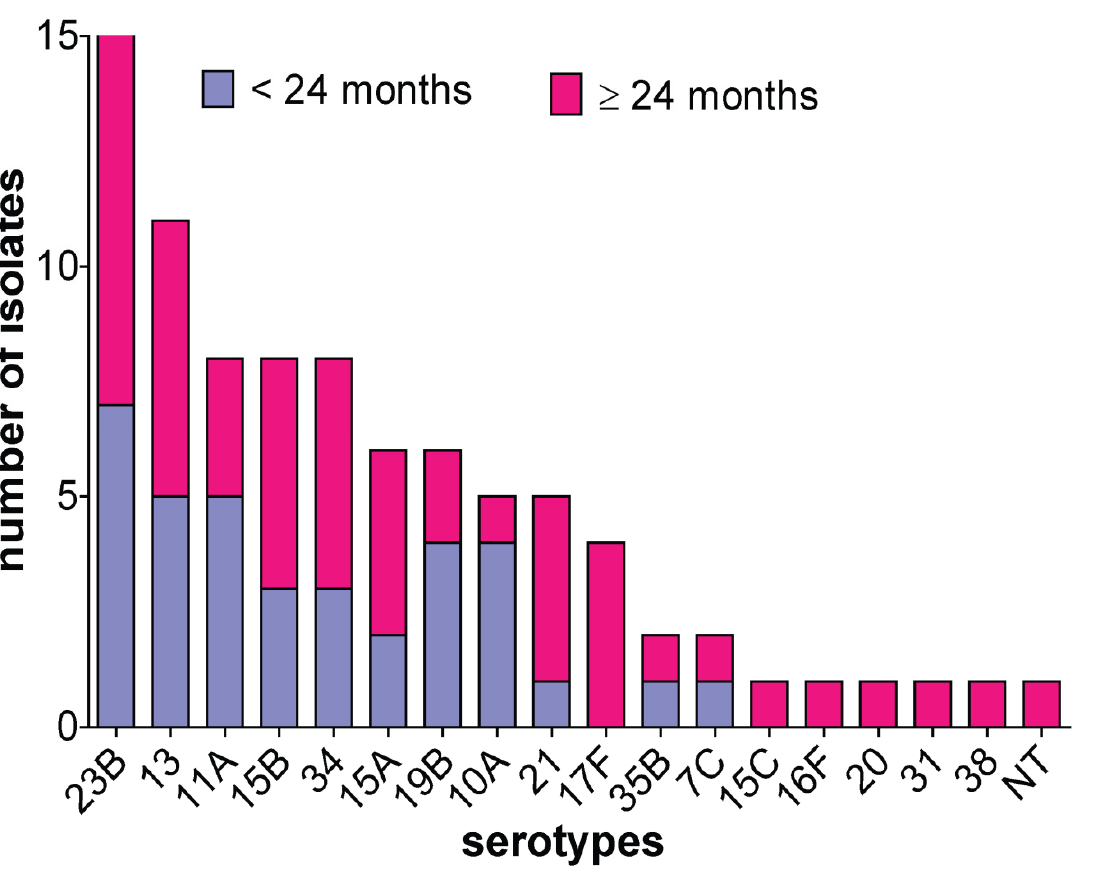
Figure 1. Non-PCV13 serotype distribution by age group. Age group ≤ 24 months includes children aged 6 months to 24 months and children 25 months to 59 months are included in the ≥ 24 months age group. NT, non-typeable.